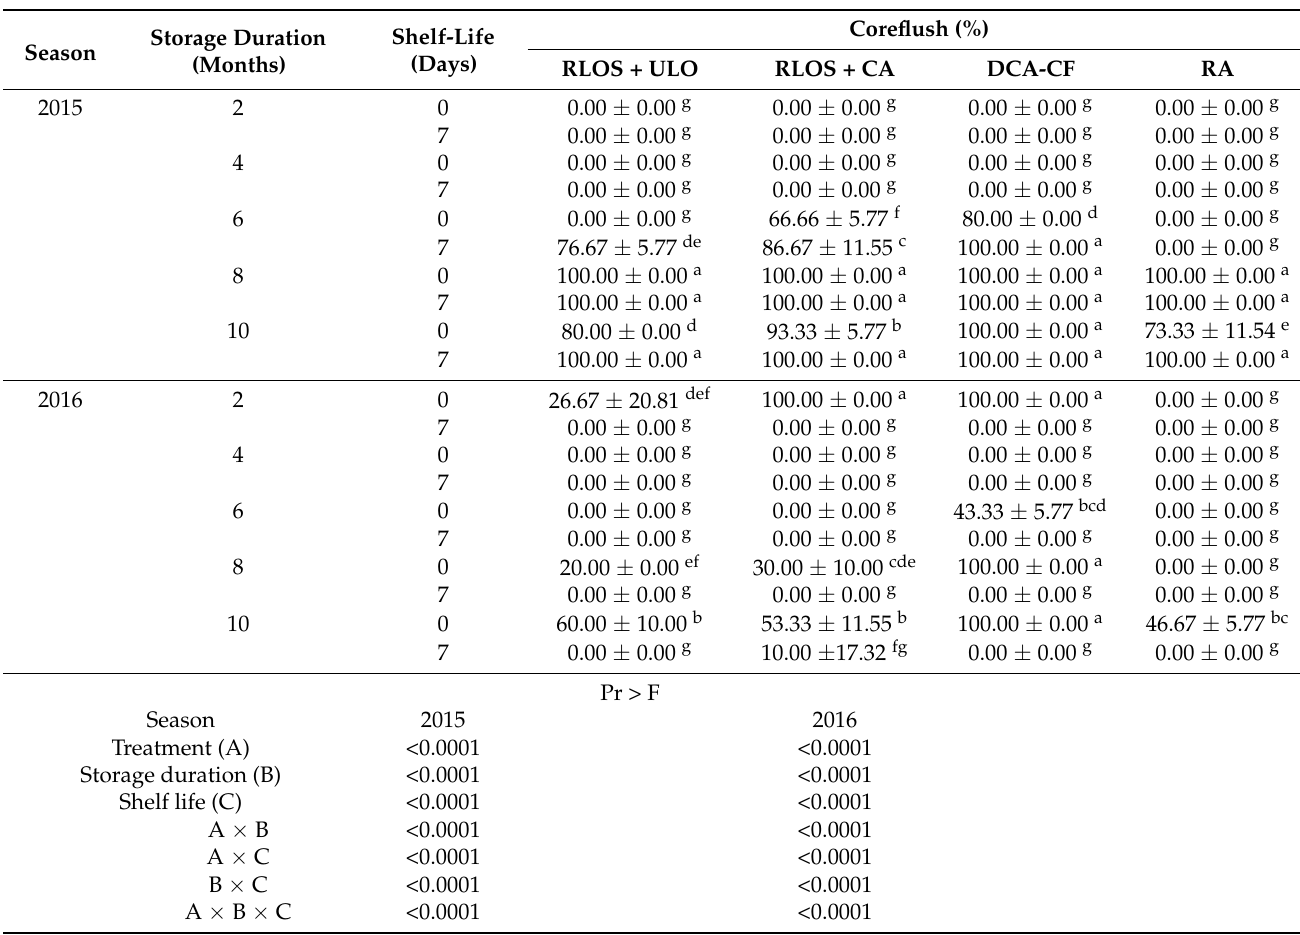
Table 2. Coreflush incidence (%) on ‘Granny Smith’ apples harvested at commercial maturity (with no coreflush incidence at harvest) and stored for up to 10 months at 0 ◦ C in various storage conditions, evaluated every two months followed by a 6 week simulated shipment and handling period, and at 7 days on the shelf (20 ◦ C and 65%